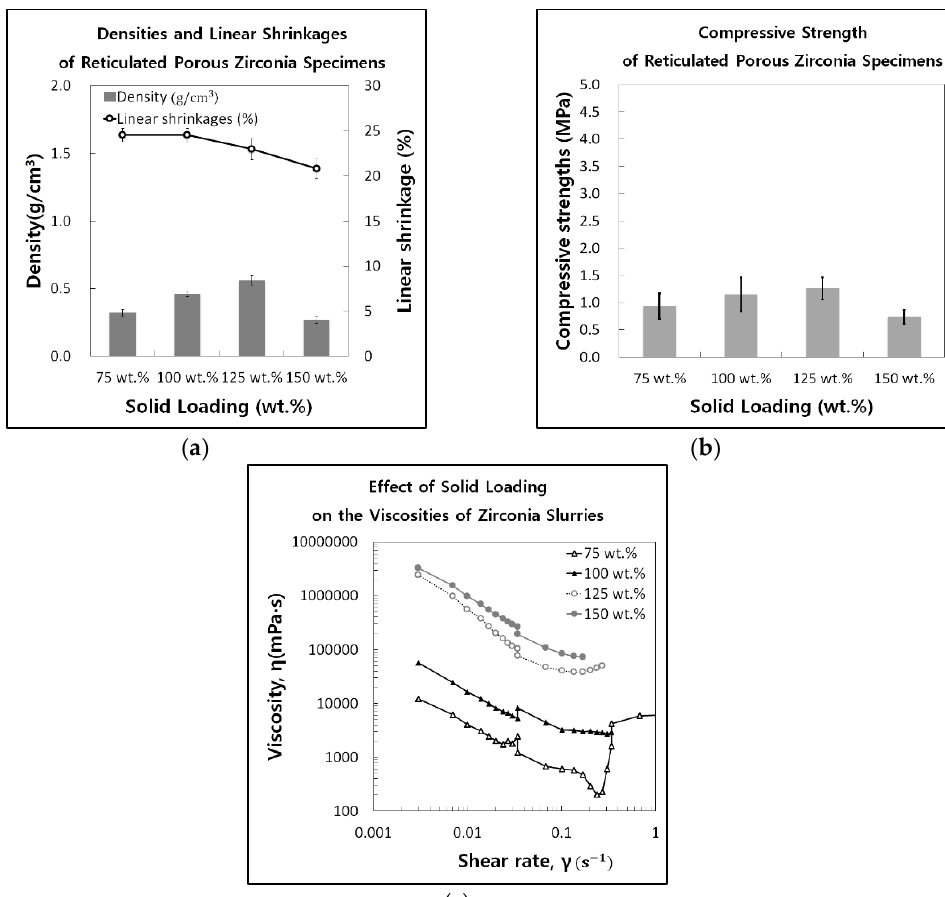
Figure 2. ( a ) Density and linear shrinkage outcomes, ( b ) compressive strength, and ( c ) viscosity values of reticulated porous zirconia specimens with different solid loading rates of 75 – 150 wt.%.